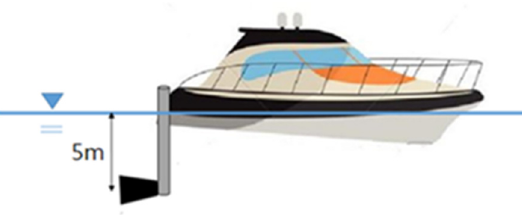
Figure 7. Schematic of the installation position of the projector.